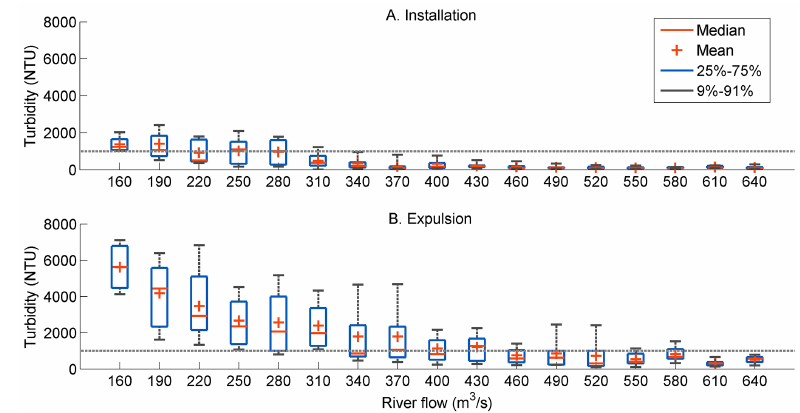
Figure 12. Mean (red cross), median (red bars), 25–75th percentile (blue bars) and 9–91st percentile (black bars) values of tidally averaged turbidity per 30m 3 s − 1 intervals of river flow during the installation and expulsion of the TMZ at Bordeaux.